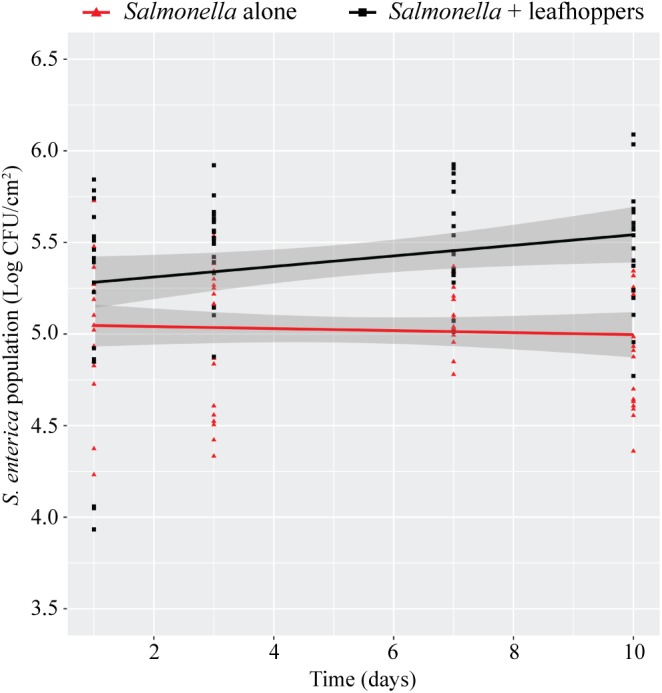
Leafhopper infestation leads to increased persistence of S. Typhimurium populations. Bacterial populations on leaves were monitored over time either in the presence (black squares) or absence (red triangles) of leafhoppers. All data points from three independent experiments were combined and presented as S. Typhimurium populations (log CFU/cm2) over a 10-day period. Lines (black, S. Typhimurium with leafhoppers; red, S. Typhimurium alone) correspond to a linear regression model, and shaded areas correspond to the respective 95% confidence interval.